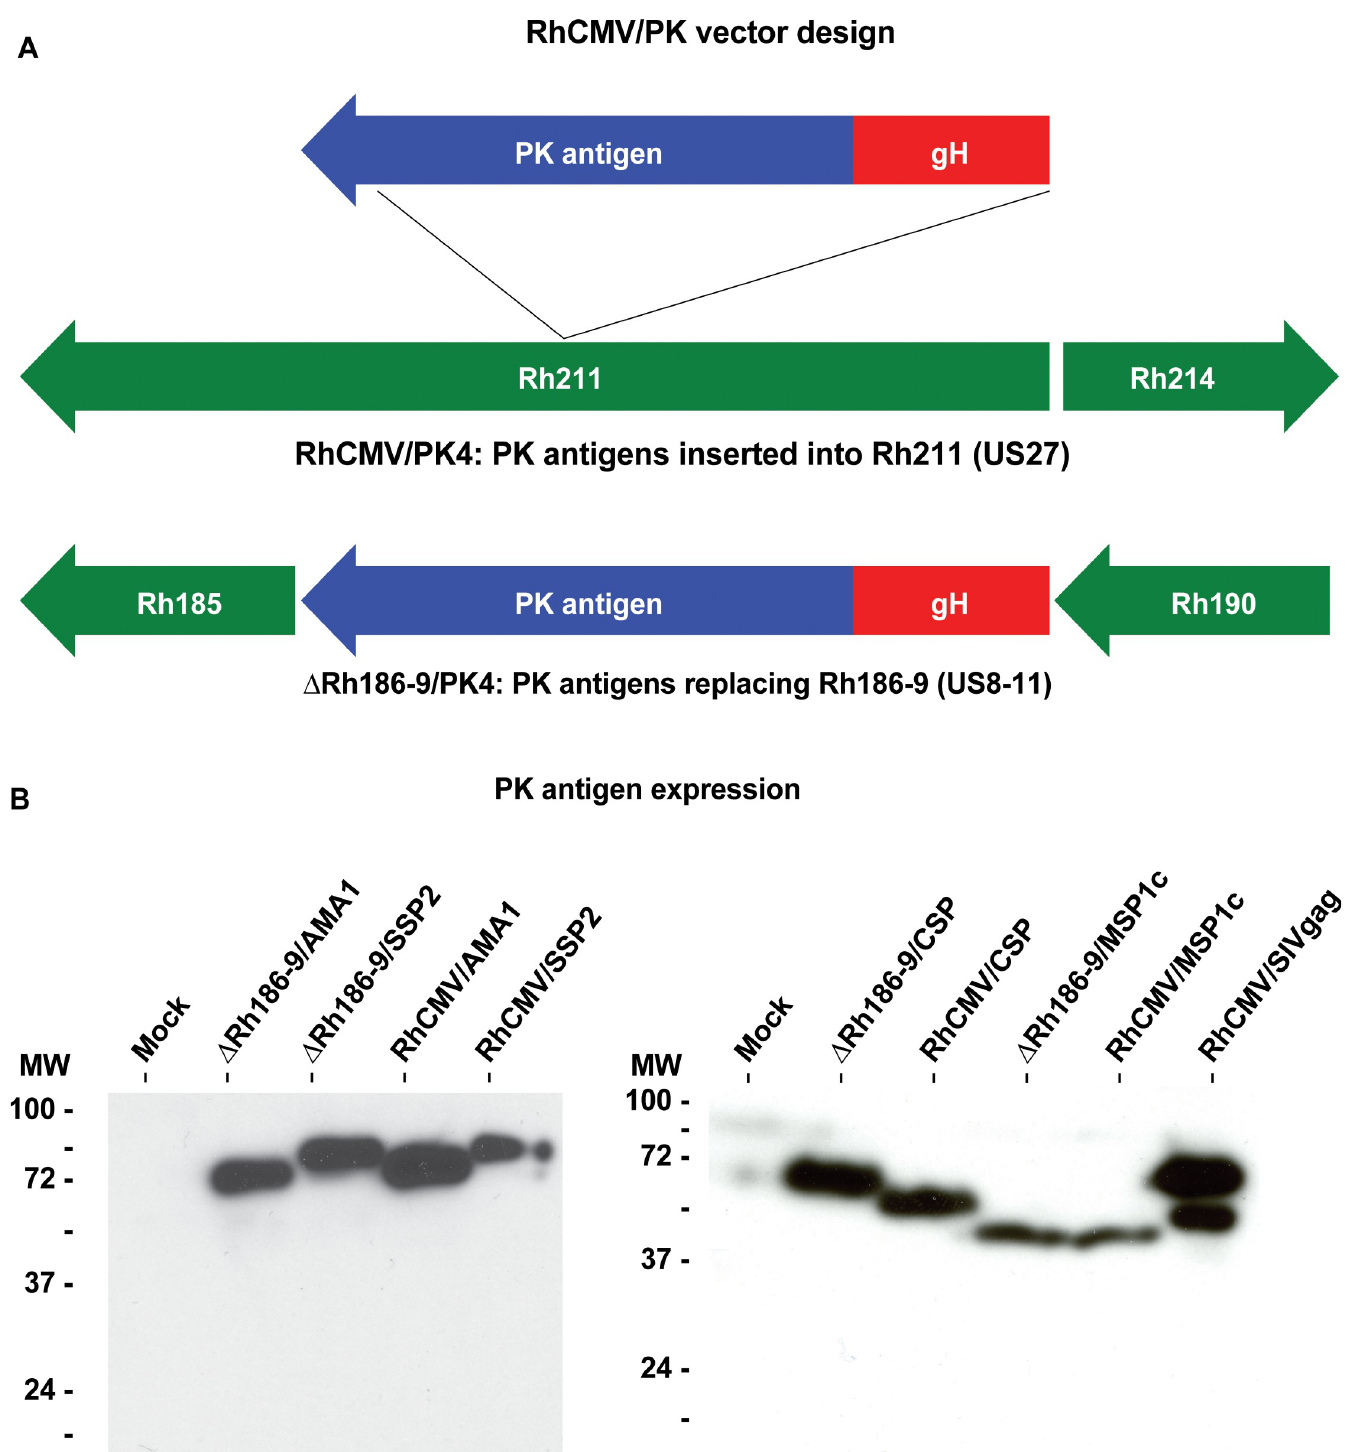
Fig 1. RhCMV vectors expressing Pk antigens. ( A) Schematic of the Pk antigen expression cassettes inserted into the RhCMV genome. Expression cassettes containing the HCMV gH promoter and codon-optimized synthetic Pk genes encoding for the proteins AMA1, CSP, MSP1c (carboxy-terminal 42 kDa fragment), or SSP2 were inserted into the Rh211 gene (US27 in HCMV) to generate the RhCMV/PK4 panel. To generate the Δ Rh186-9/PK4 panel, the expression cassettes were used to replace the gene region Rh186-189 encoding the RhCMV homologs of HCMV US8-11. To facilitate detection, the PK4 antigens were fused to the FLAG epitope sequence at their carboxy-terminus. (B) Immunoblots of Pk antigen expression by RhCMV vectors. Lysates of rhesus fibroblasts infected (MOI = 3) for 24 hours with RhCMV/PK4